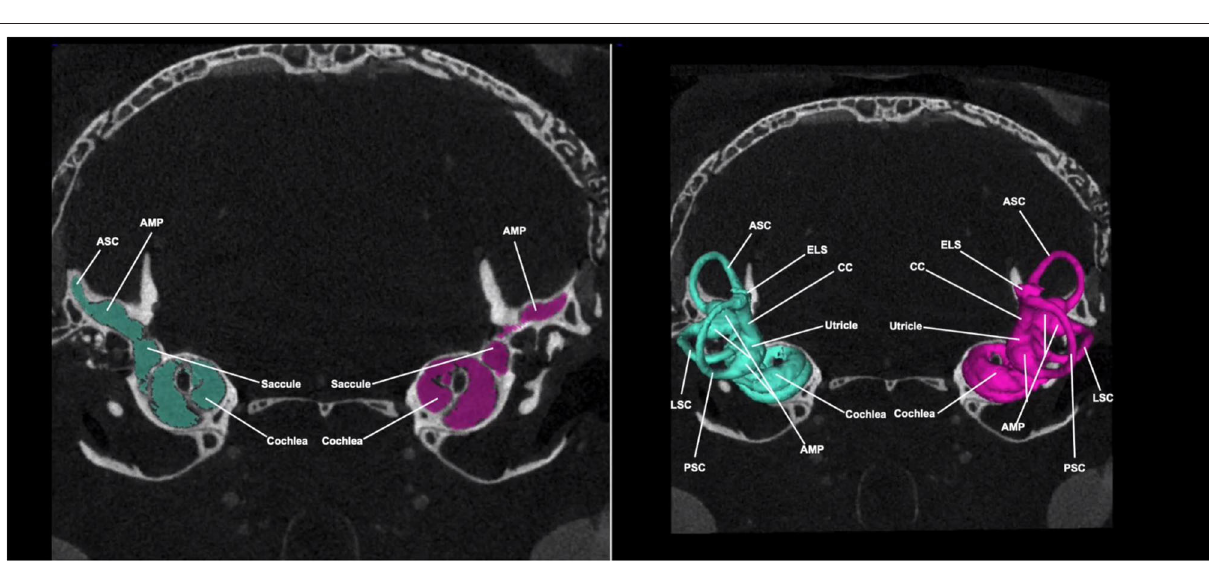
throughout the postnatal period, which have not